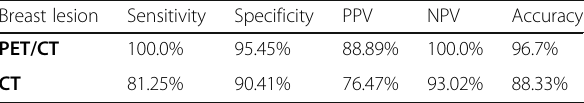
Table 3 Sensitivity, specificity, accuracy, and positive and negative predictive values of FDG-PET/CT and contrast- enhanced CT in all breast lesions cases Breast lesion